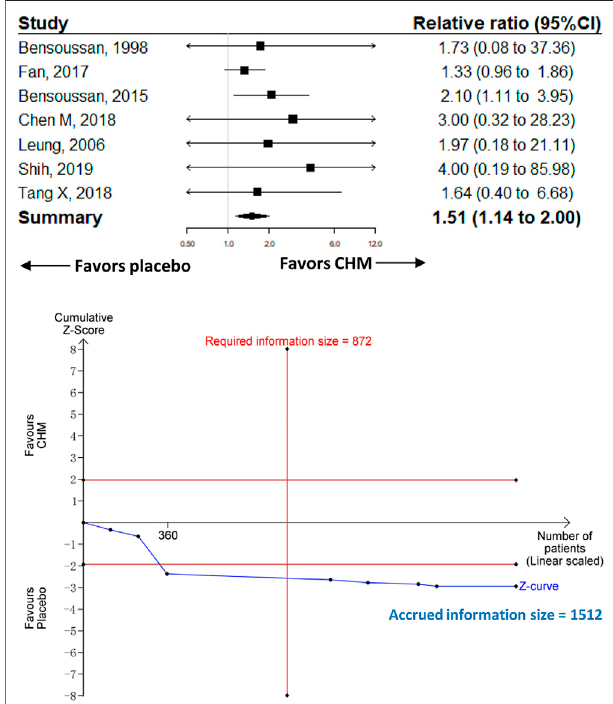
FIGURE 4 | Meta-analysis and TSA analysis of CHM vs. placebo in the treatment-related adverse events. CHM, Chinese herbal medicine. TSA, trial sequential analysis. The results of meta-analysis were shown on the top half, and the results of TSA were shown on the bottom half. The red vertical line represented the RIS for the comparison, assuming a difference of 5% in the rate of treatment-related adverse events. The blue line represented the cumulative Z curve, and the black dots represented the included studies added according to their publication year in ascending order.